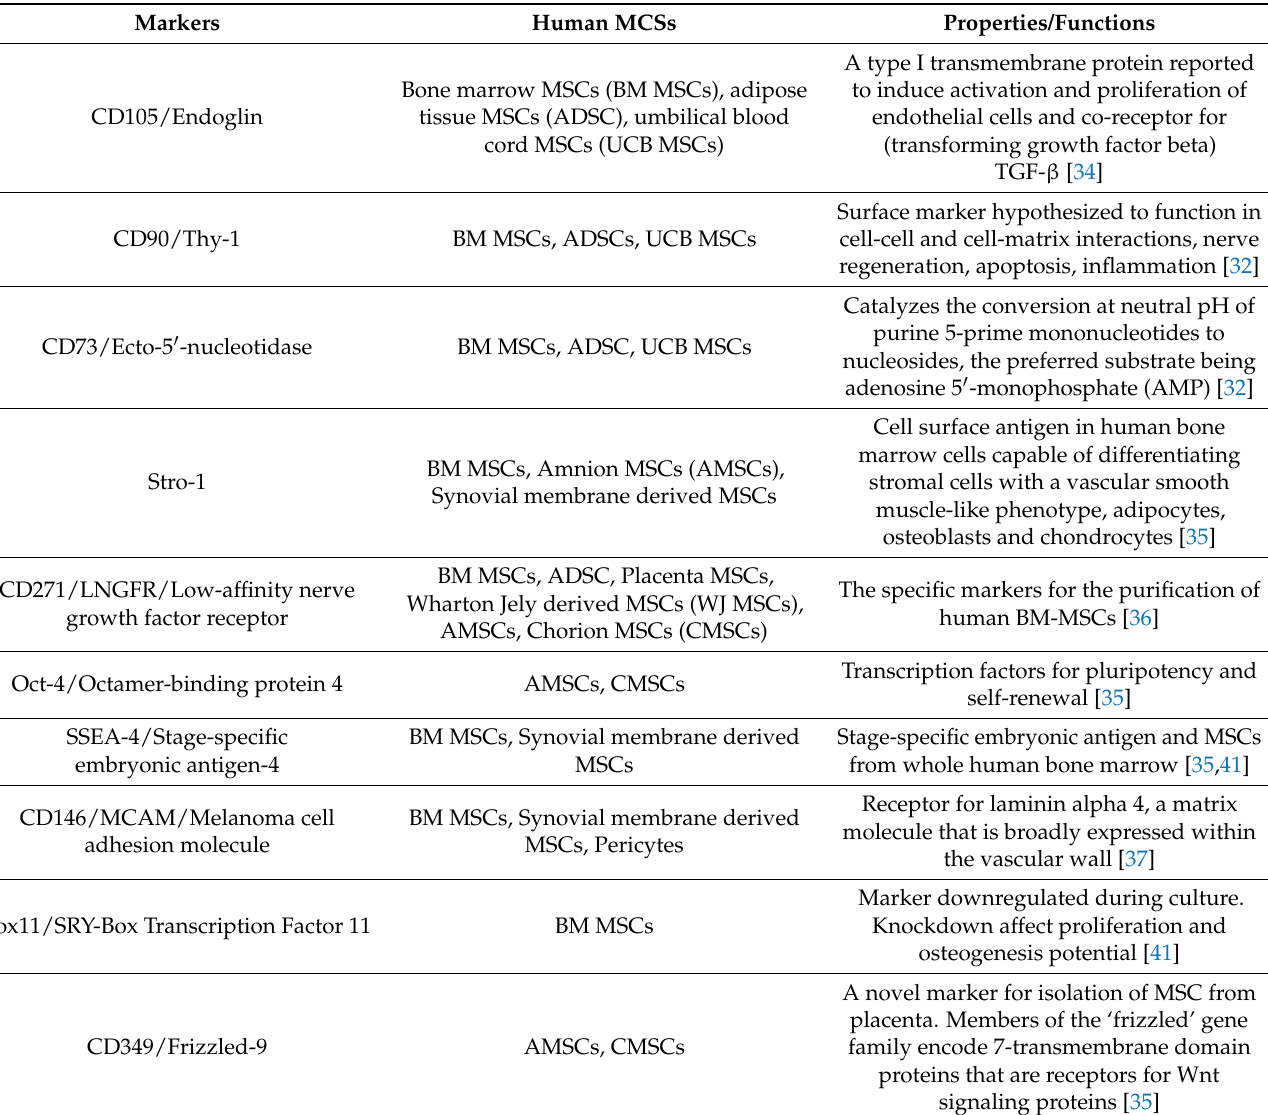
Table 3. The surface markers and identity of human mesenchymal stem